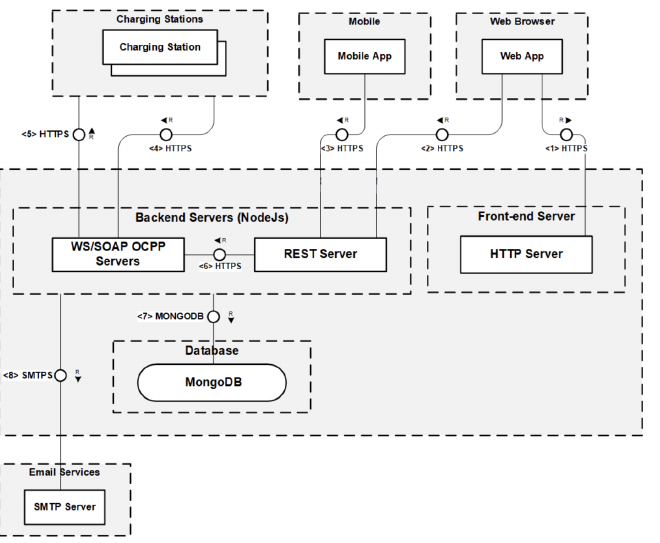
Figure 4. High-level system architecture of “Open E-Mobility”. Reprinted with permission from [36]. 2022, SAP Labs